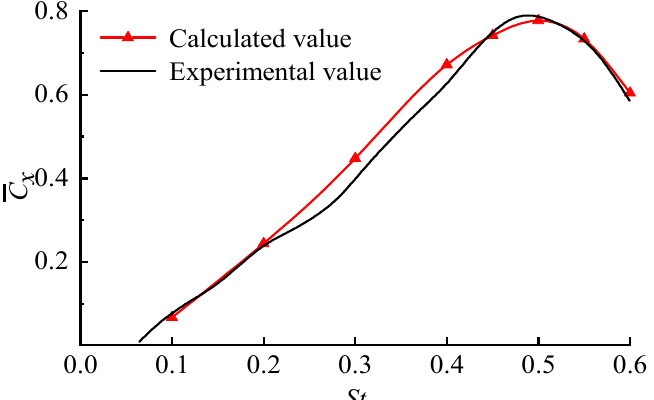
Figure 5. Comparison between numerical simulation results and experimental data in the literature [24].